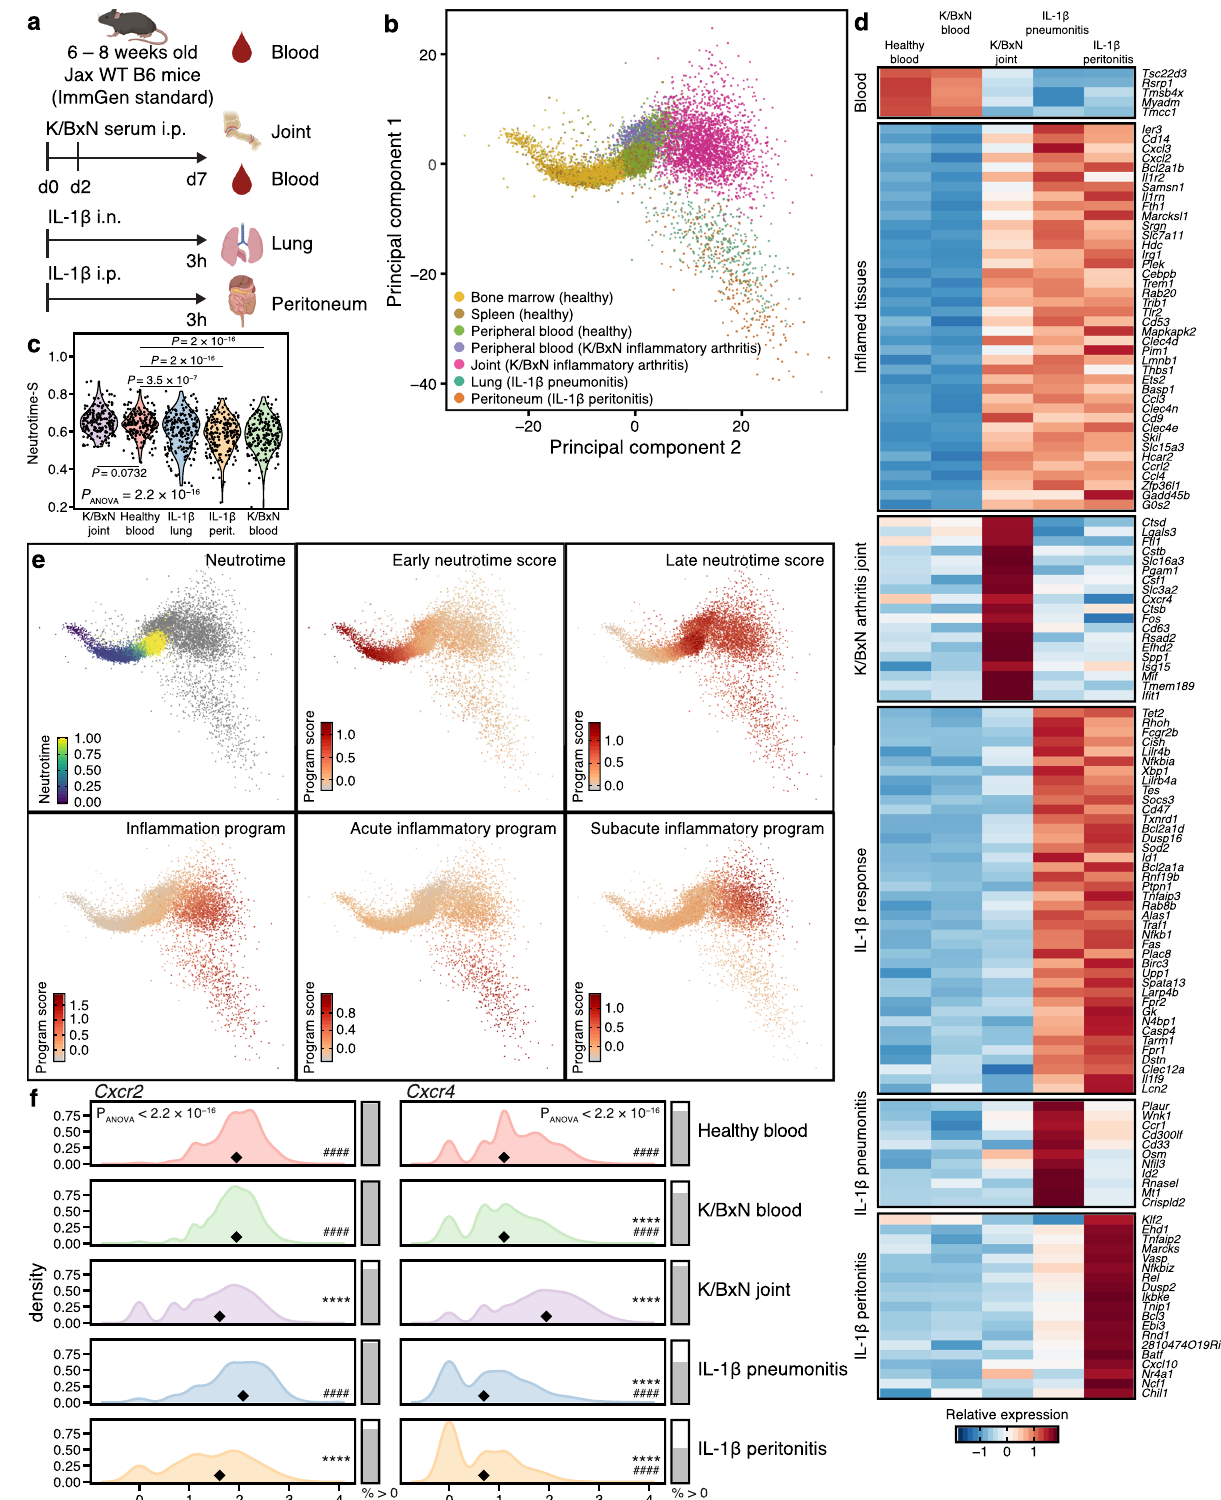
fl ow cytometry, expressed as change with respect to healthy blood neutrophils. As expected, the relationship between transcript and protein proved highly variable (Supplementary Fig. 11). This result illustrates the importance of caution in the extrapolation of transcriptional phenotype to cell function and highlights the strength of the transcript-only approach to cell ontology as rea- lized in